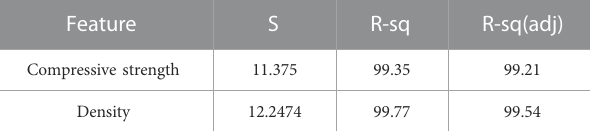
TABLE 5 Summary of the regression